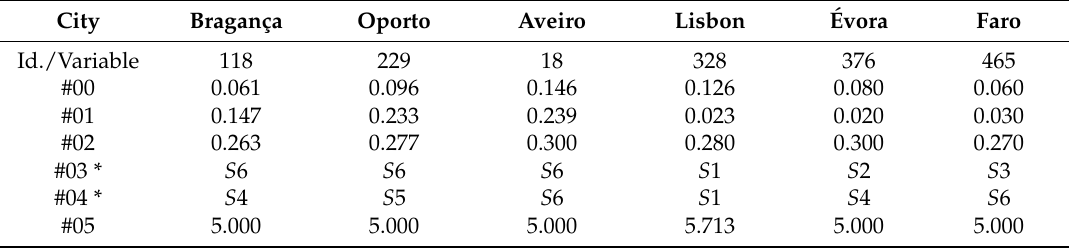
Table 9. LCC results for the best Pareto front solutions for different climate regions. City Bragança Oporto Aveiro Lisbon É vora Faro Id./Variable 118 229